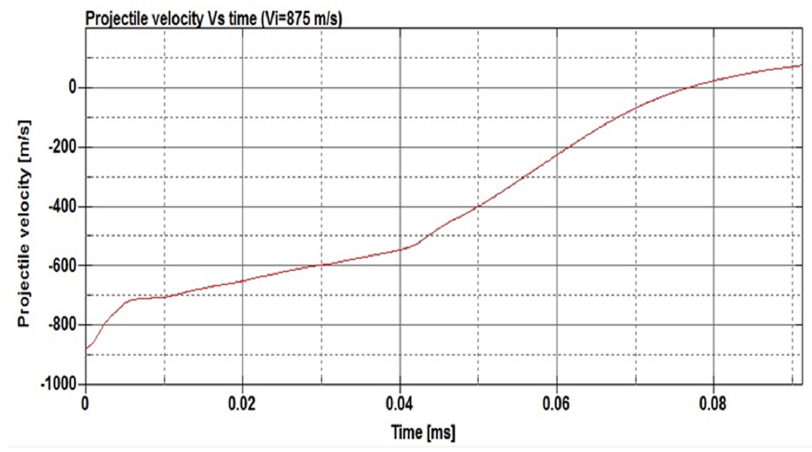
Figure 12. Projectile velocity vs. time for the NiTi auxetic structure at a projectile speed of 875 mm/s.